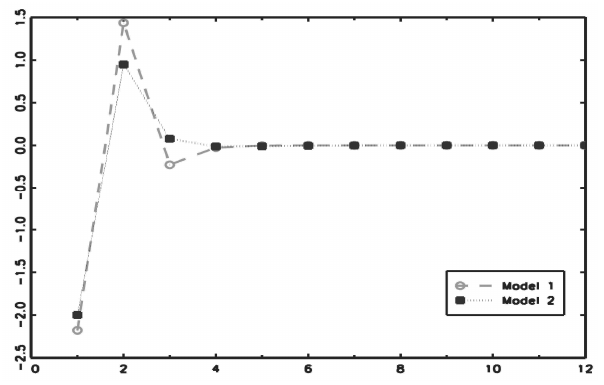
Figure 1 – Autoregressive coefficients obtained by two models for the same